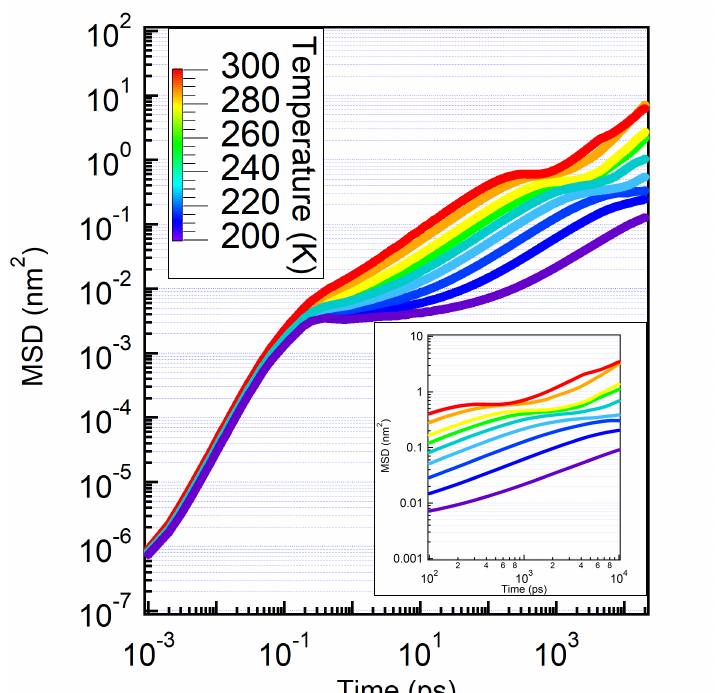
Figure 8. Mean Square Displacement. Particles shows a sub-diffusive behaviour at high temperatures until they reach a new plateau that starts at 100 ps for T = 300 K. This feature is related to the plateau that we see in Figure 7 and which is different from the one that we observe for the low temperatures, which is related to the MCT